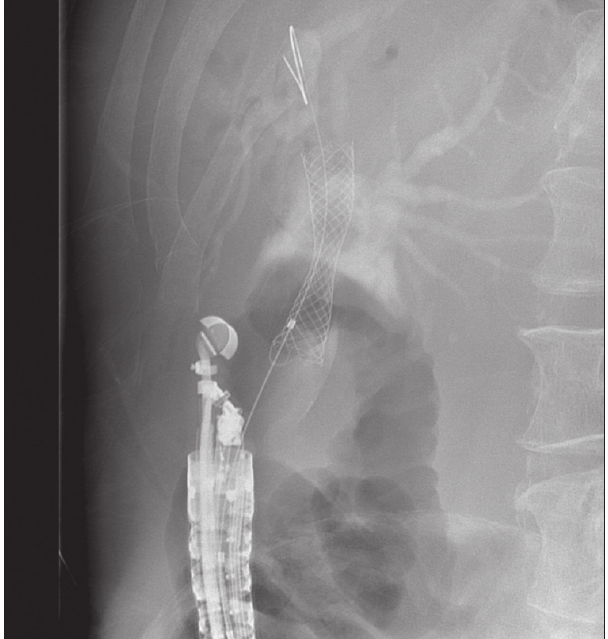
Figure 4) Stent deployment under fluoroscopic guidance